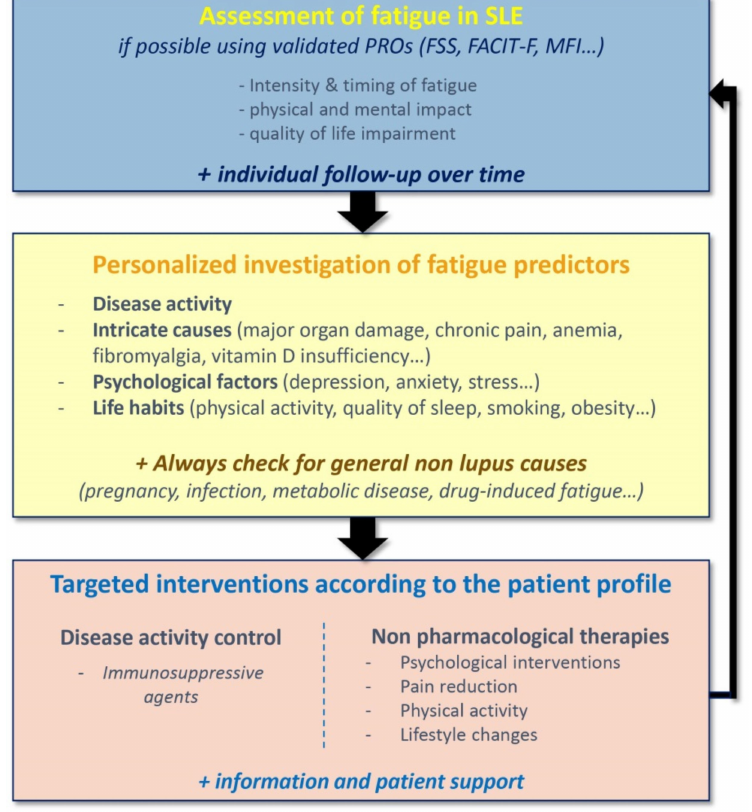
Figure 2. Personalized strategy for the assessment of fatigue in Systemic Lupus Erythematosus. FSS: Fatigue Severity Scale; FACIT-F: Functional Assessment of Chronic Illness Therapy—Fatigue; MFI: Multidimensional Fatigue